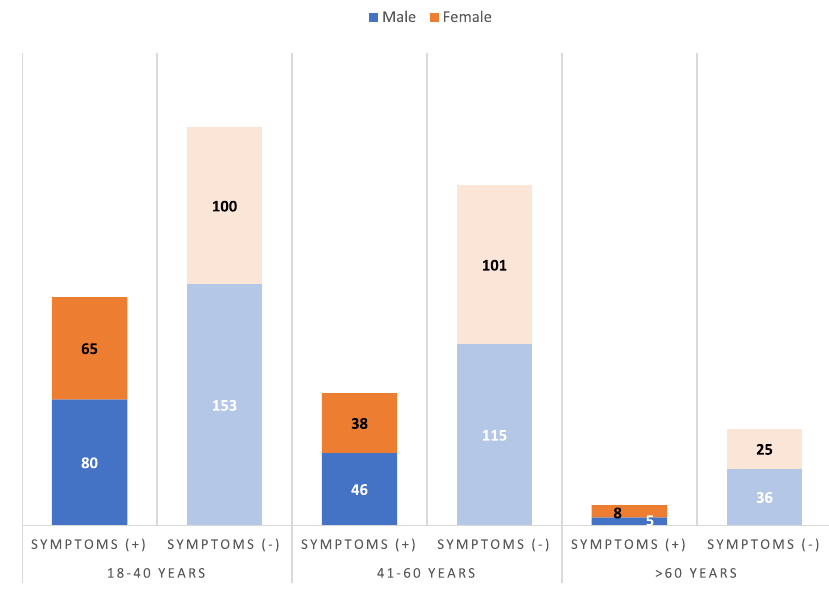
Fig. 1 Age and sex distribution of patients with and without OTD